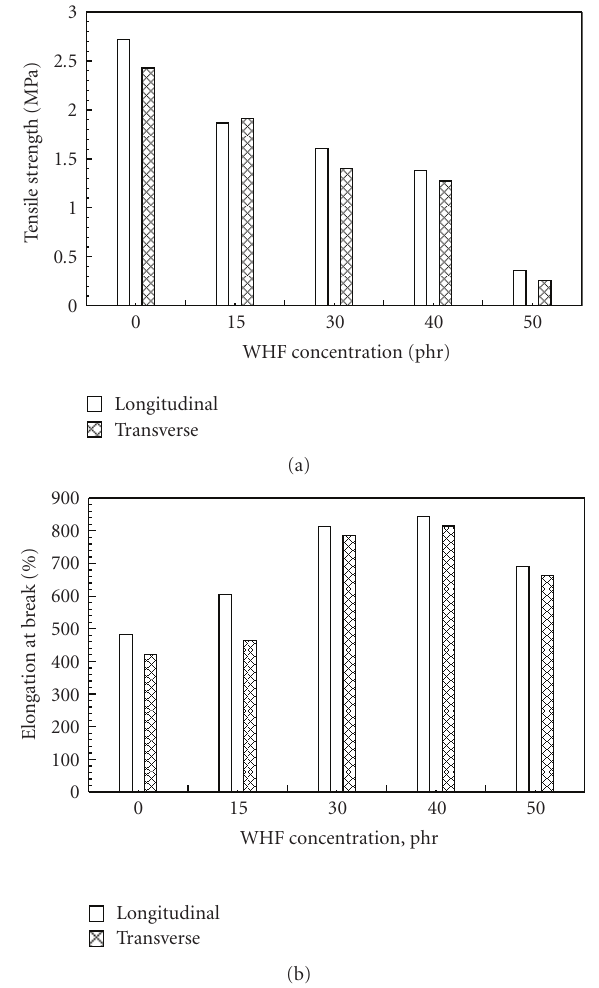
Figure 2: (a) Tensile strength and (b) elongation at Break, %, at di ff erent concentrations of WHF-filled EPDM composites.